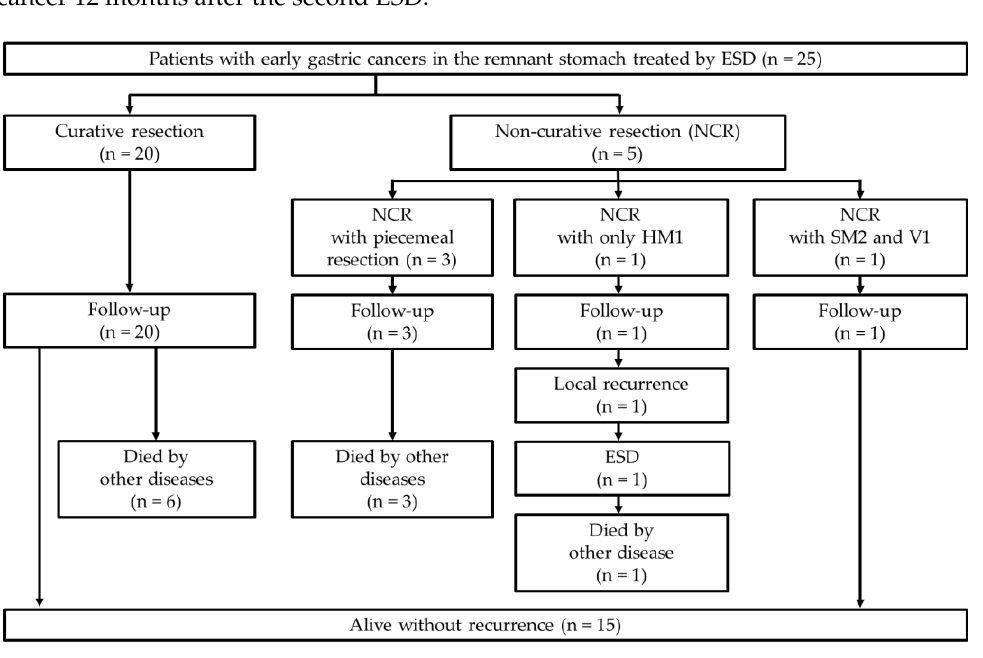
Figure 2. Clinical course flow diagram of the 25 patients. HM, horizontal margin; SM, submucosa; V, venous invasion; ESD, endoscopic submucosal dissection.